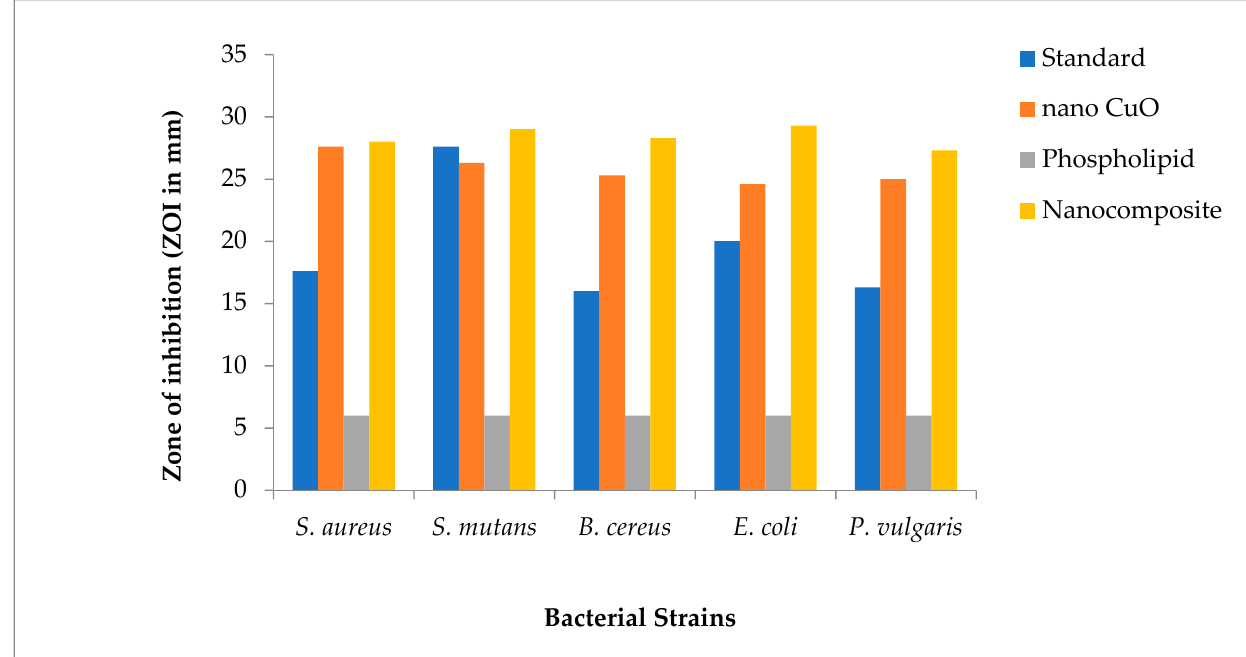
Figure 4. Graphical representation of comparative data for antibacterial activity of nanocomposites.